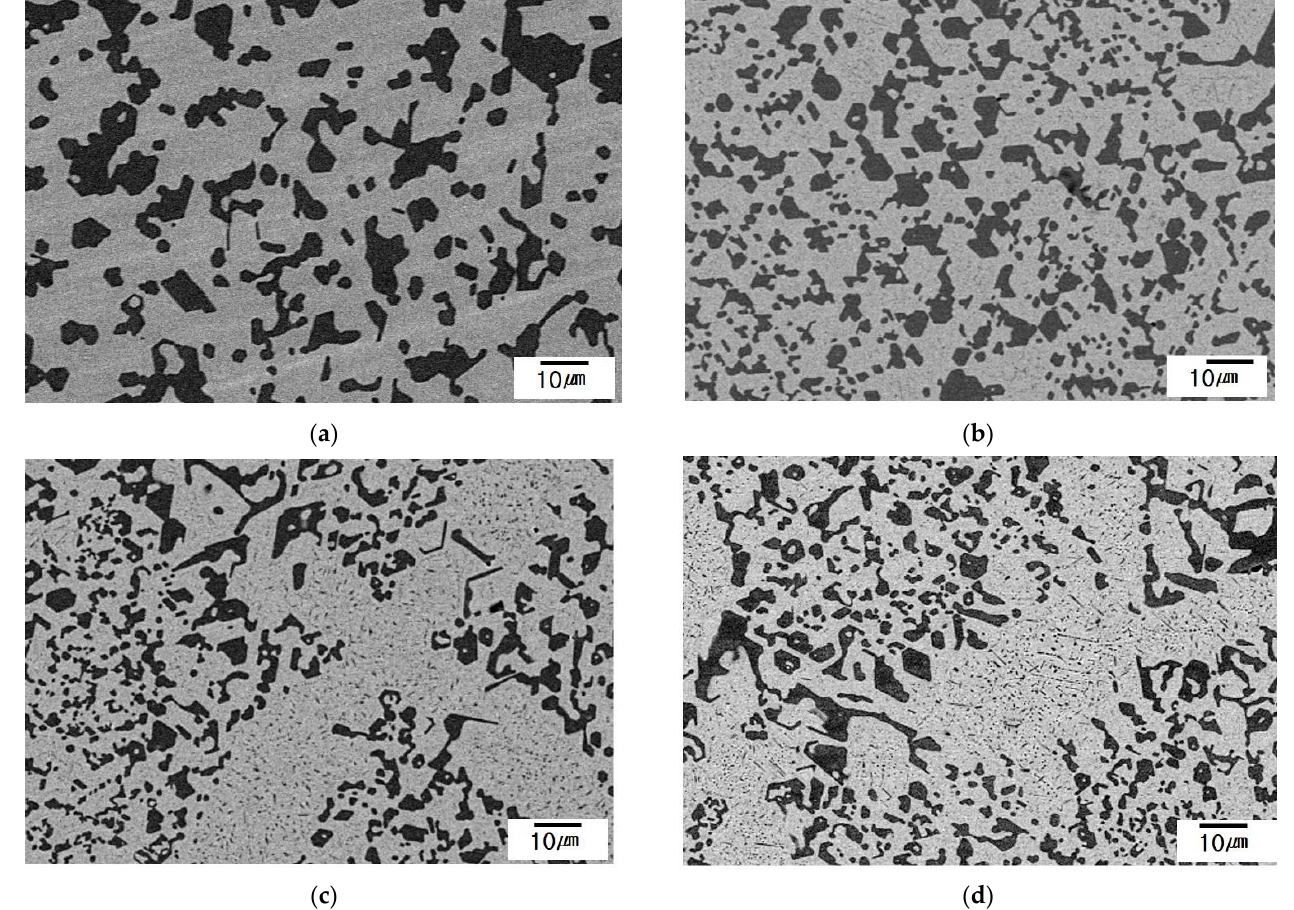
Figure 6. Micrographs normal to the solidified direction. ( a ) 1 µ m/s; ( b ) 10 µ m/s; ( c ) 25 µ m/s; ( d ) 50 µ